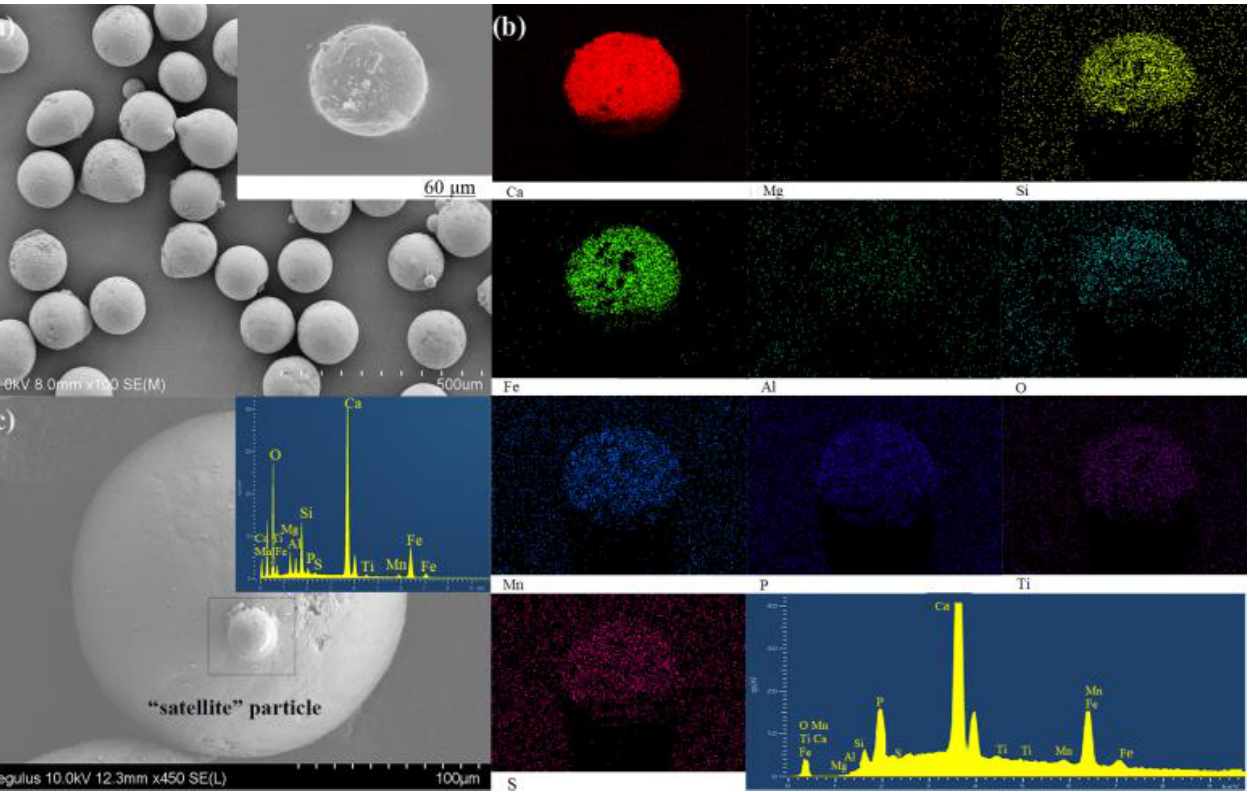
Figure 2. SEM and EDS images of the sample (( a,c ) SEM; ( b )